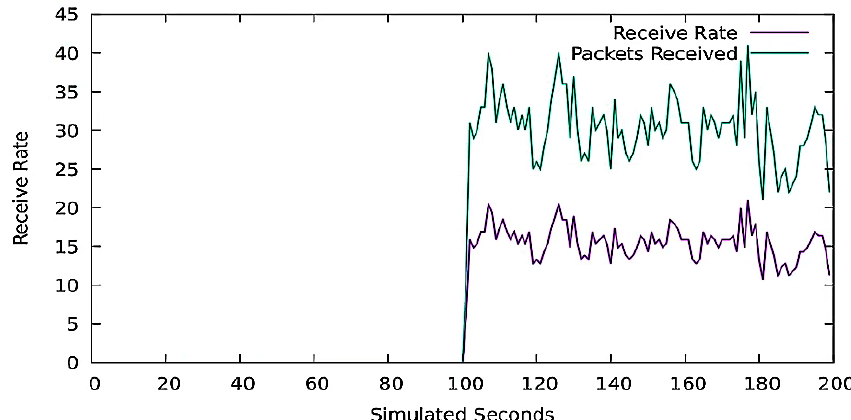
Figure 16. The stats in the normal network.